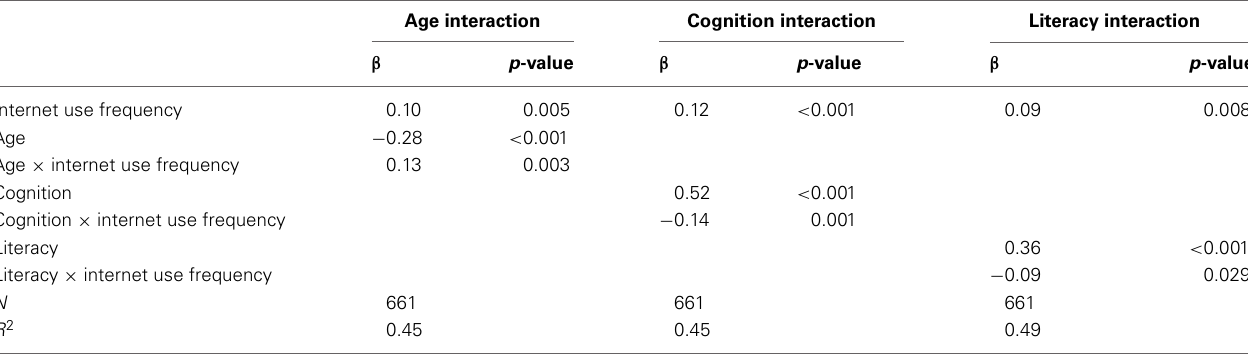
Table 4 | Significant interactions of internet use frequency with covariates on healthcare and financial decision making (dependent variable) * . Age interaction